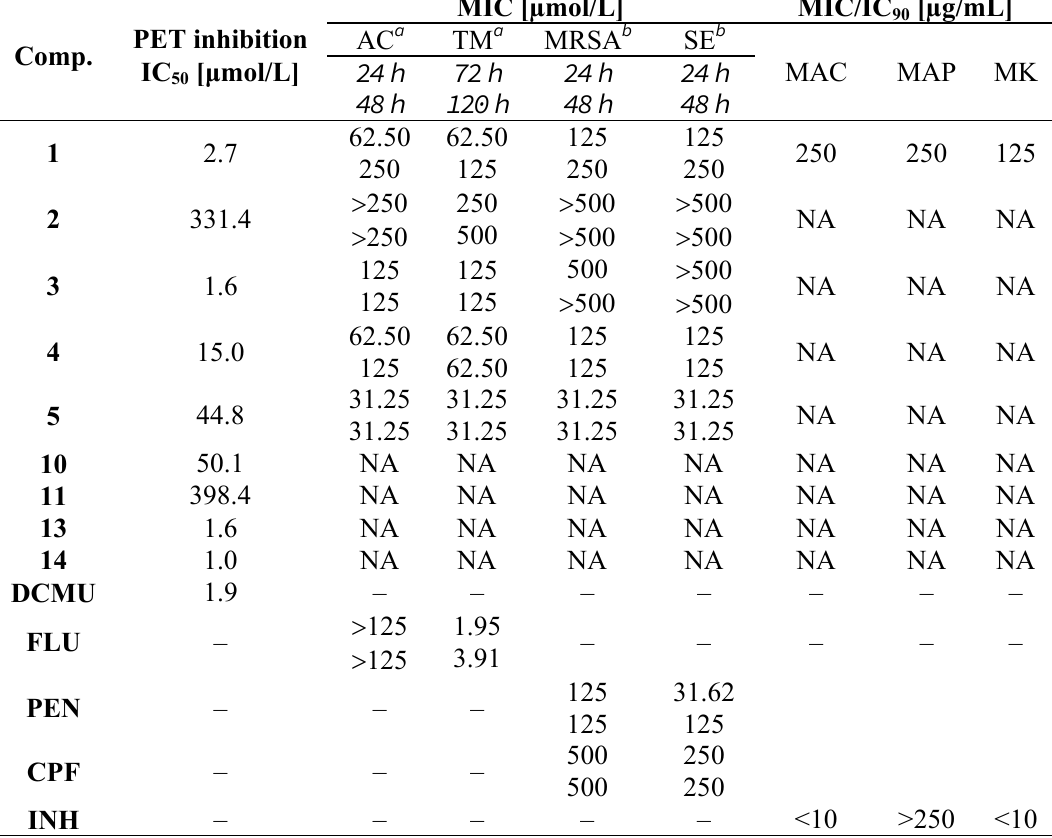
Table 2. IC values of compounds 1 - 11 , 13 and 14 related to photosynthetic electron 50 transport (PET) inhibition in spinach chloroplasts in comparison with the 3-(3,4-dichlorophenyl)-1,1-dimethylurea (DCMU) standard; in vitro anti-fungal and /IC ) of compounds 1 - 5 compared with the fluconazole (FLU), anti-bacterial activity (IC 50 90 penicillin G (PEN), ciprofloxacin (CPF) standards and the anti-mycobacterial activity (IC ) of compound 1 in comparison with the standard isoniazid (INH). 90